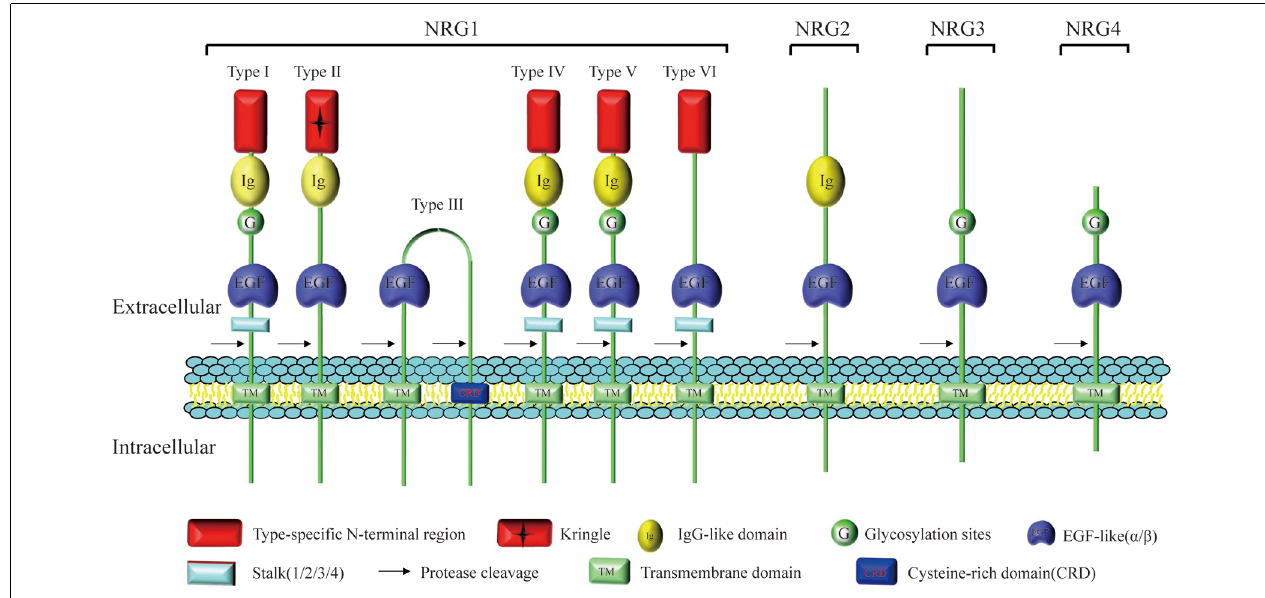
FIGURE 1 | Structure and homology of neuregulin (NRG). All NRG isoforms contain a fragment encoding an epidermal growth factor (EGF)-like domain which regulates the association of NRG ligands with the ErbB receptor tyrosine kinase family. Different splicing of NRG1 gene can produce at least six NRG1 (I–VI) subtypes characterized by different extracellular domains, but only types I, II, IV, and V contain the Ig-like domain. Type II NRG1 contains a GGF-specific (“Kringle”) domain and type III NRG-1 contains a unique cysteine rich domain (CRD). NRG2 is most closely related to NRG1, and NRG1–3 exhibit high primary sequence homology, especially near the transmembrane (TM) domain. Compared with other NRGs containing multiple domains, such as the Ig-like domain, cysteine-rich domain (CRD) or mucin-like domain, NRG4 does not contain these recognizable domains except the EGF-like